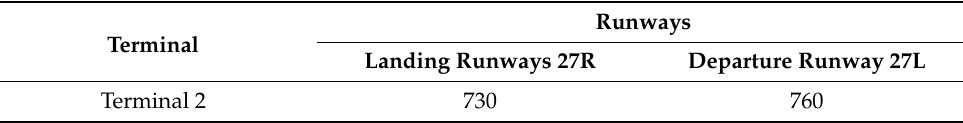
Table 2. Average taxi time (s).